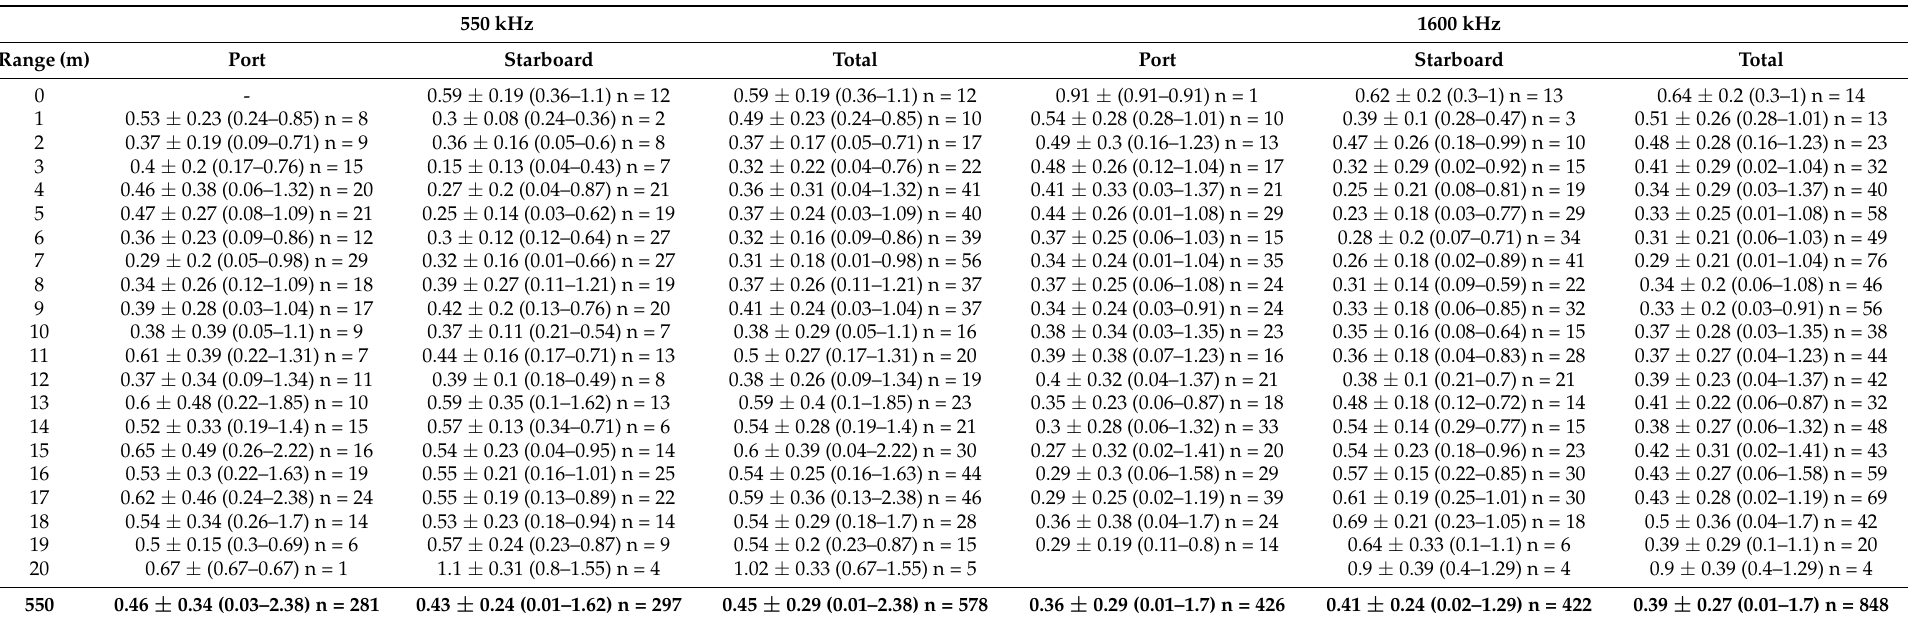
Table 4. Summary statistics for both frequencies (550 and 1600 kHz) from the Provincetown Harbor survey across the swath range (0–20 m). Data for distance bin (mean ± standard deviation (min–max)) for both port and starboard and each frequency are displayed. All units are in meters. 550 kHz 1600